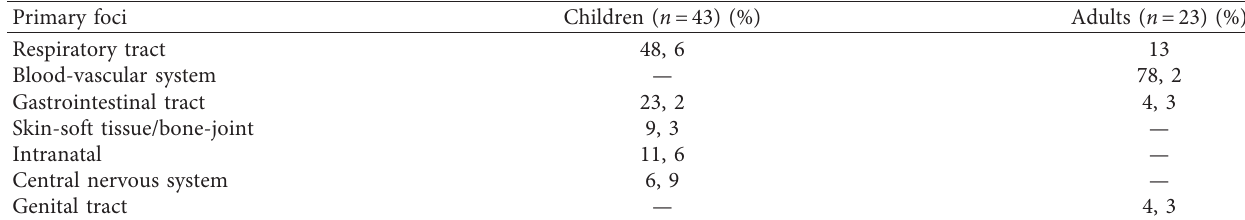
Table 2: Primary foci of infection in patients with